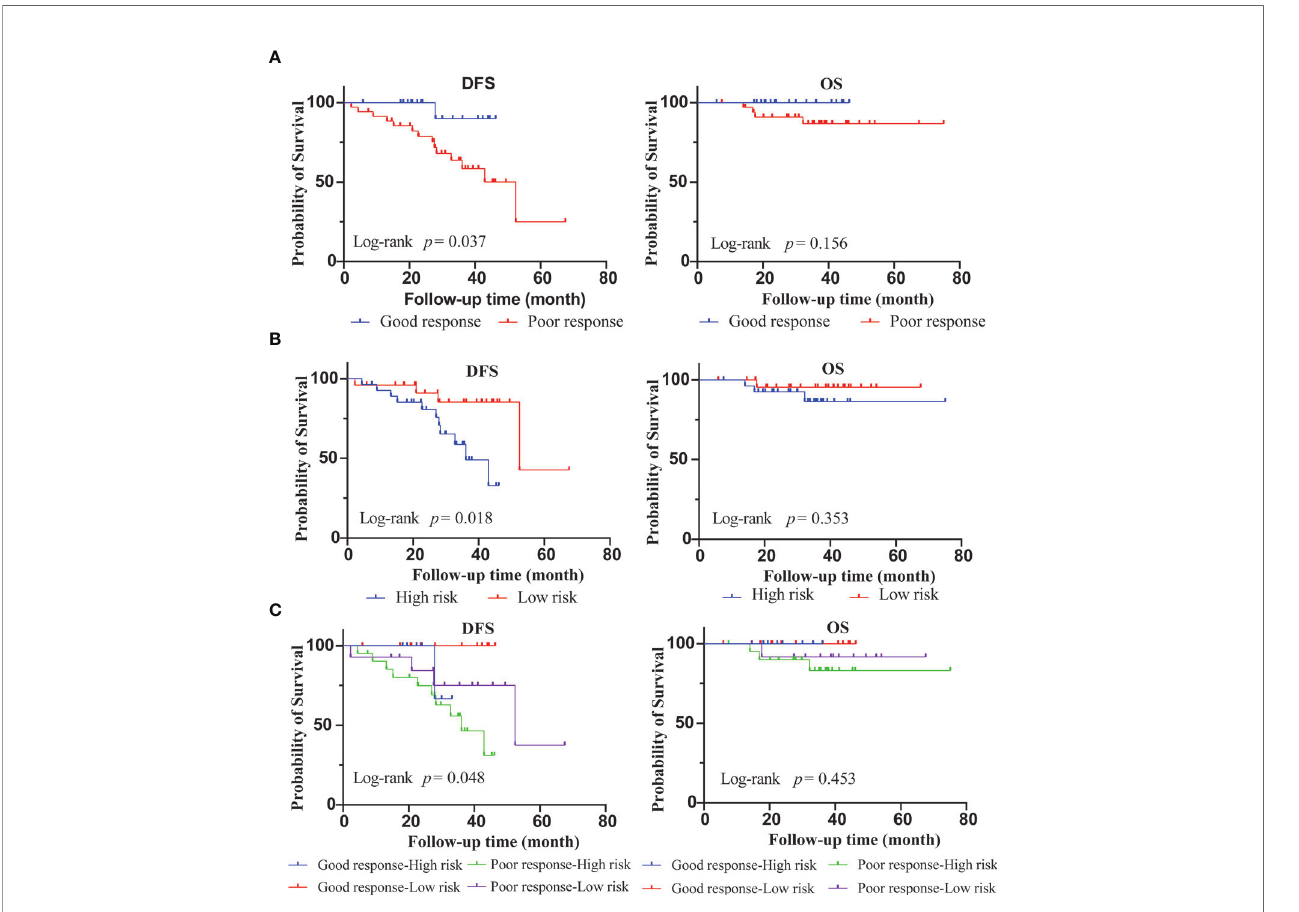
FIGURE 3 | Disease-free survival (DFS) and overall survival (OS) according to Miller – Payne grades (A) and MammaPrint evaluation (B) . Kaplan-Meier DFS and OS estimates for combinations of Miller – Payne grades and MammaPrint evaluation (C)